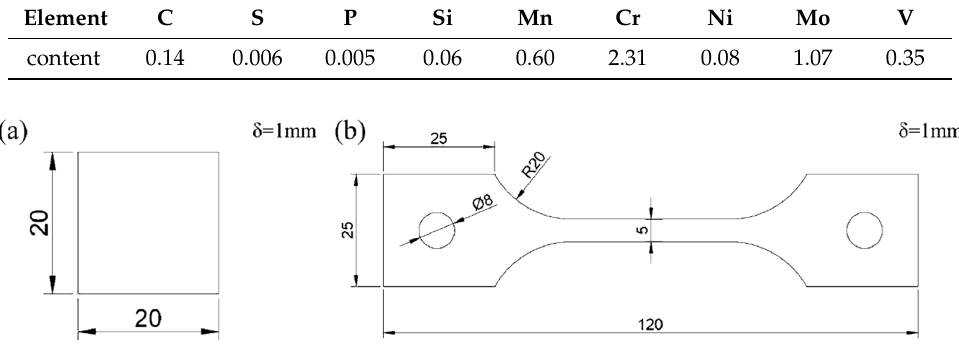
Figure 1. The size of specimens: ( a ) Glycerol gas collecting test sample; ( b ) Tensile test specimen. Table 1. Chemical composition of test specimen (wt %).